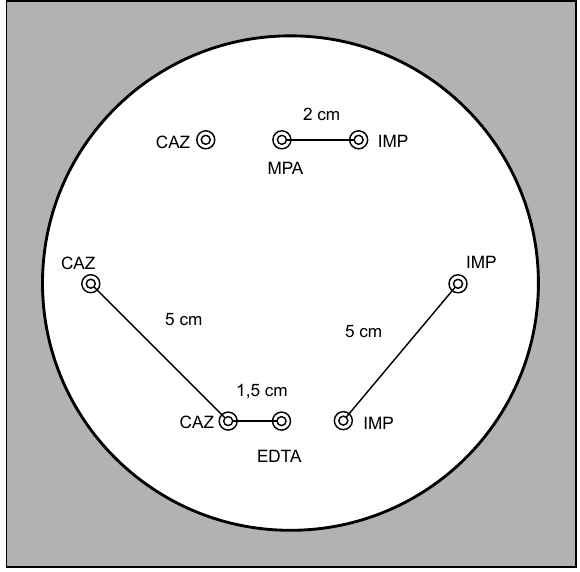
Figura1 – Representação esquemática da disposição, em placa contendo ágar Mueller Hinton, dos discos contendo os agentes quelantes e antimicrobianos utilizados no